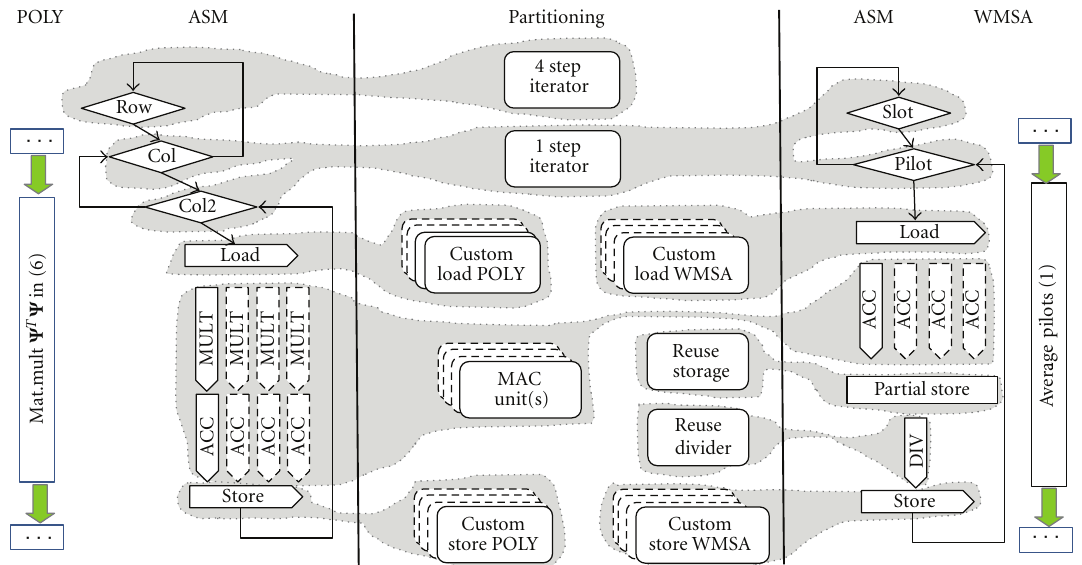
Figure 8: Partitioning of a piece of the ASM chart of the applications, reusing common points across applications and exploiting parallelism.